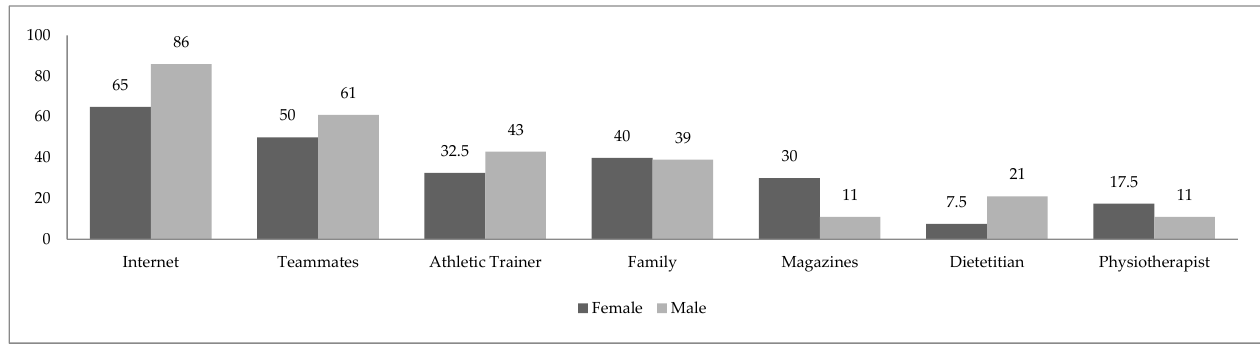
Figure 1. Comparison of rationale for taking dietary supplements in female and male group, pre- sented as proportion of each cohort (%).